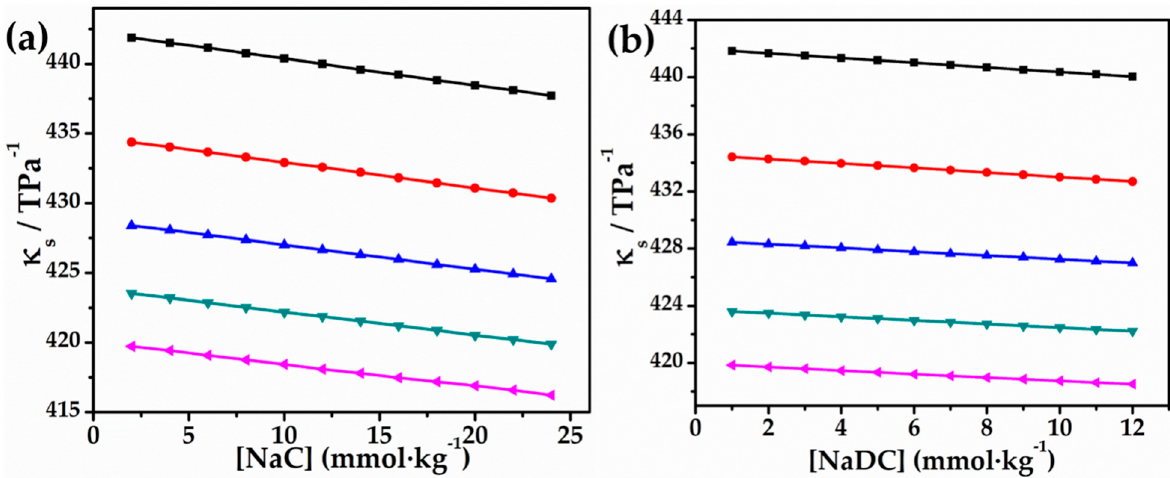
κ Figure 2. Plots of s vs. ( a ) [NaC] and ( b ) [NaDC] in 0.010 mol ∙ kg –1 aqueous solution of glycyl (cid:4) ), 298.15 K ( • ), 303.15 K ( (cid:78) ), 308.15 K ( (cid:72) ), and 313.15 K ( (cid:74) glycine at 293.15 K ( ■ ), 298.15 K ( ● ), 303.15 K ( ▲ ), 308.15 K ( ▼ ), and 313.15 K ( ◄ ). glycine at 293.15 K (